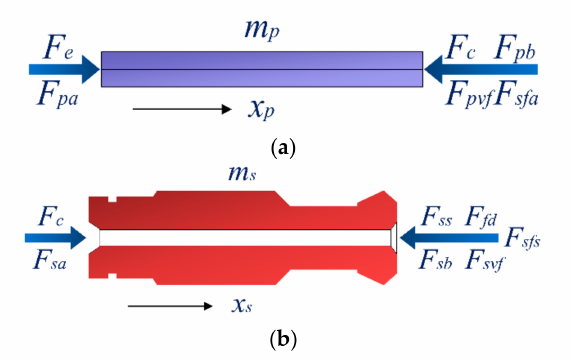
Figure 3. SCV mechanics dynamic model: ( a ) forces on the armature; ( b ) forces on the